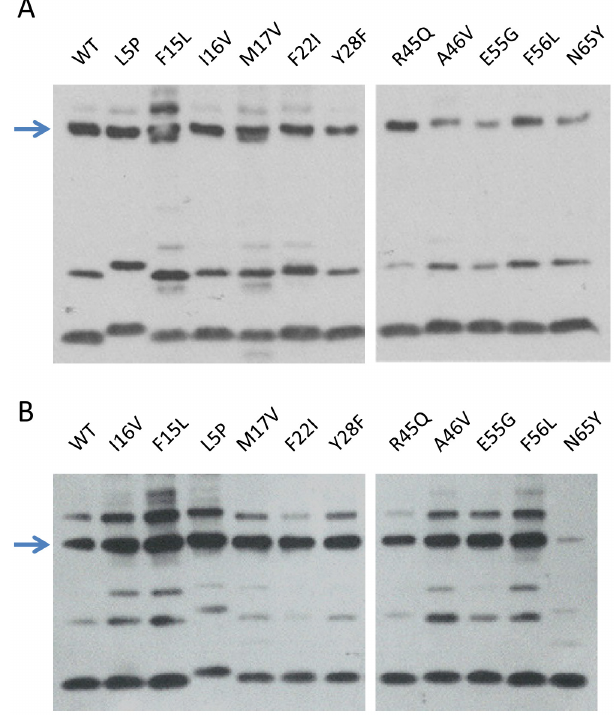
Figure 6. IntS and TorR binding to TorI mutants. A, binding assay of TorI mutants (10 µM) in the presence of IntS (10 µM). B, binding assay of TorI mutants (10 µM) in the presence of TorR (10 µM). Arrows indicate the major